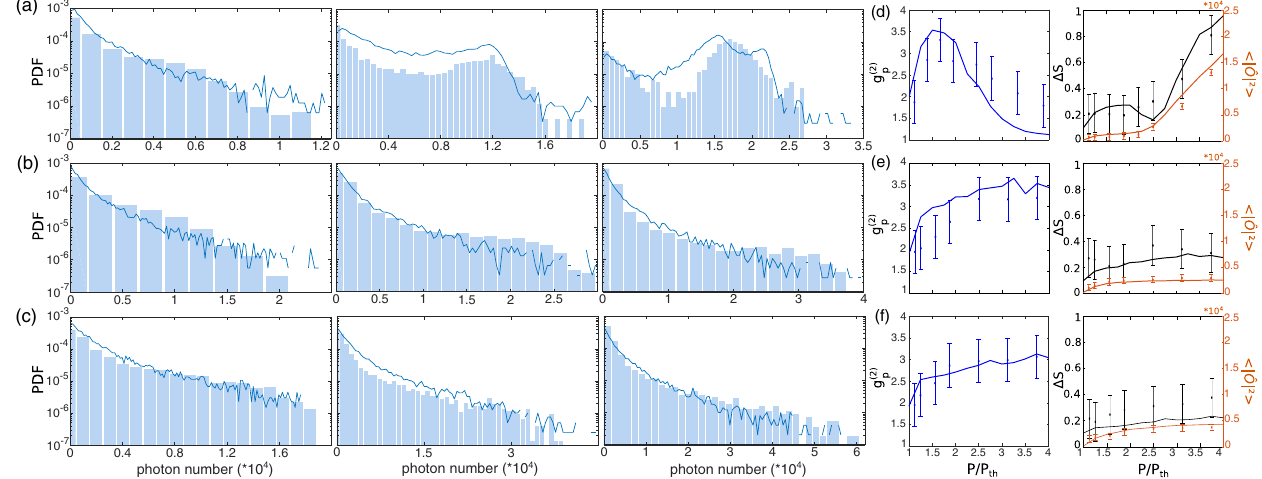
FIG. 3. Statistical distributions of the photon number for the B -mode. (a) – (c) Experimental (bars) and theoretical (lines) PDFs for increased pump powers P ¼ 1 . 5 P (left), P ¼ 2 P (middle), and P ¼ 3 P (right) and different intercavity coupling levels: th th th (a) K ¼ 3 . 3 , (b) K ¼ 6 , and (c) K ¼ 10 . (d) – (f) Experimental (symbols) and theoretical (lines) degree of second-order coherence (left); excess entropy (right, black); and order parameter (right, orange) as a function of P for (d) K ¼ 3 . 3 , (e) K ¼ 6 , and (f) K ¼ 10 . In the 28 numerical simulations, γ ¼ − 0 . 1 , α ¼ 5 , and γ − 1 tot ¼